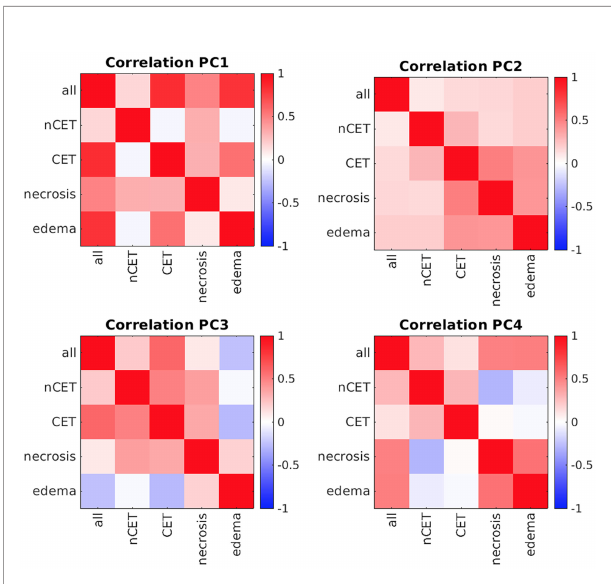
FIGURE 3 | Correlation matrixes between principal components (PCs) across tissues. Positive correlations are represented in red, while negative correlations are in blue. All , whole tumor including edema; nCET , non- contrast-enhancing tumor; CET , contrast-enhancing